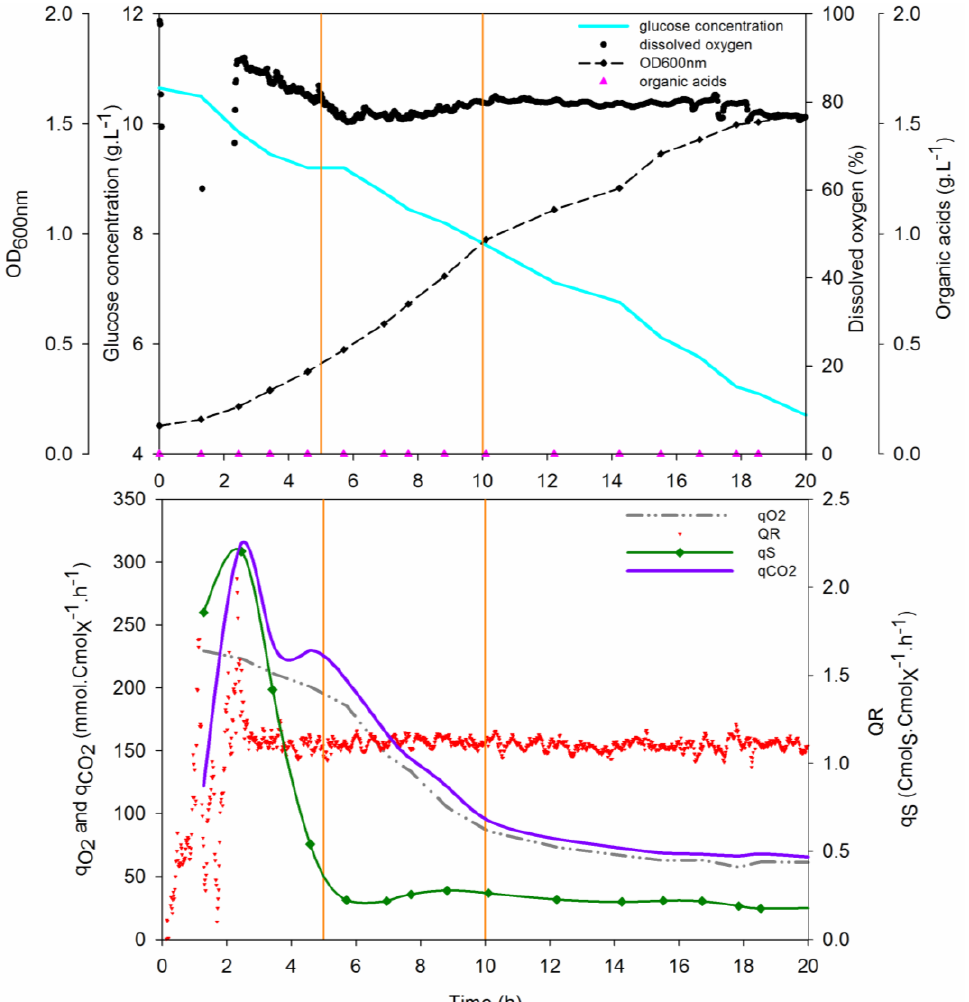
Figure 3. Time course evolution of the optical density OD 600 nm , the glucose concentration, the dissolved oxygen value, the acidic by-products concentration, the respiratory quotient (QR) and the specific oxygen uptake, carbon dioxide production and glucose uptake rates during batch culture of Deinococcus geothermalis DSM-11302 (vertical bars represent the three phases of